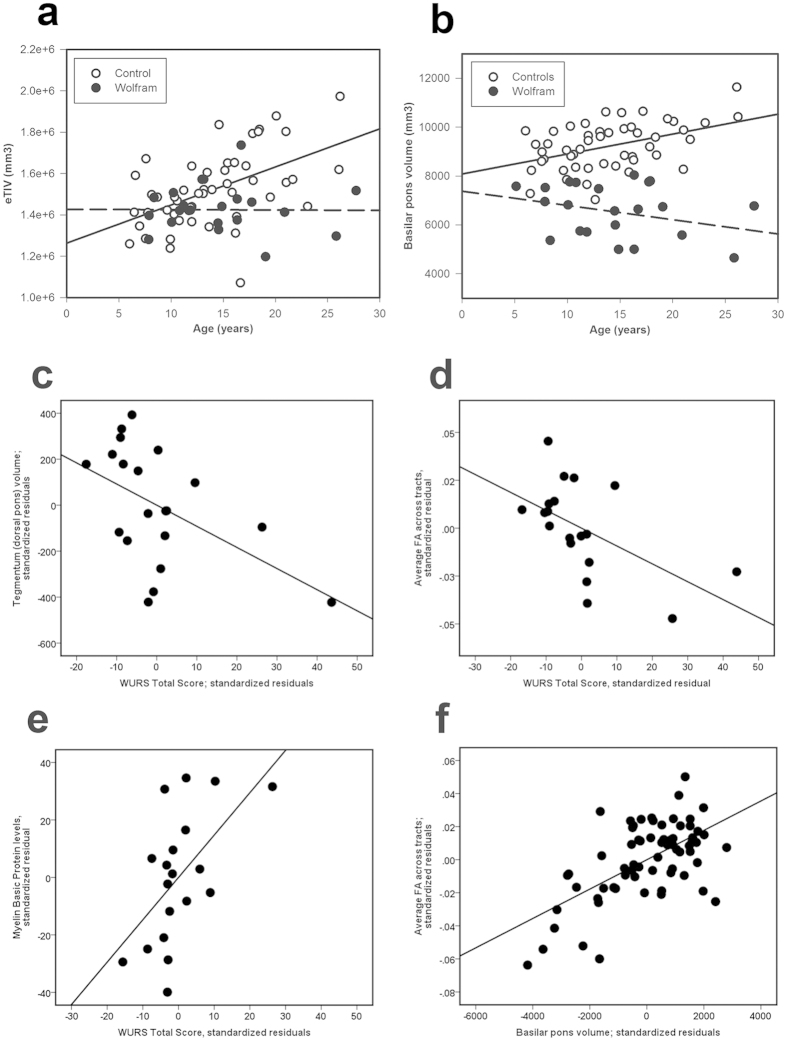
Scatterplots of brain measures with significant age by group interactions, as well as significant brain-behavior and brain-brain relationships within the Wolfram group only.Significant age by group interactions were seen in (a) eTIV (F1,66 = 7.47, p = 0.008) and (b) basilar (ventral) pons (F1,66 = 7.65, p = 0.007). Correlations were seen between the WURS Total Score (higher scores are worse) and (c) tegmentum (dorsal pons) volume (r15 = −0.50, p = 0.040; higher volume is better), (d) average FA across tracts (r15 = −0.52, p=0.022; higher levels are better), and (e) myelin basic protein levels (r14 = 0.604, p = 0.013; higher levels are worse), after controlling for age and gender. (f) In addition, basilar pons volume correlated with average FA (r16 = 0.569, p = 0.014). All brain volumes were also corrected for intracranial volume. Abbreviations: WURS, Wolfram Syndrome Rating Scale; FA, fractional anisotropy.